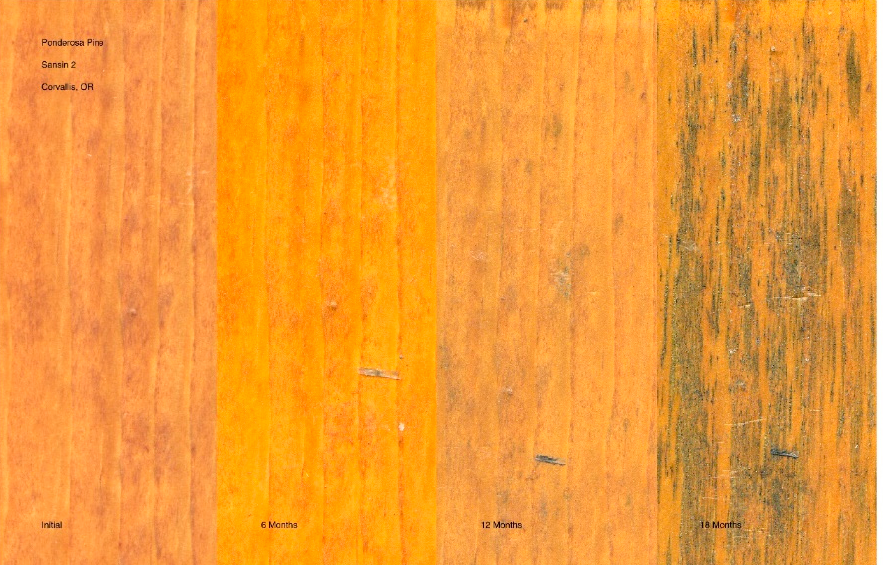
Figure 22. Example of the same ponderosa pine sample treated with Sansin 2 and exposed on a test fence near Corvallis, OR for 0, 6, 12, and 18 months.